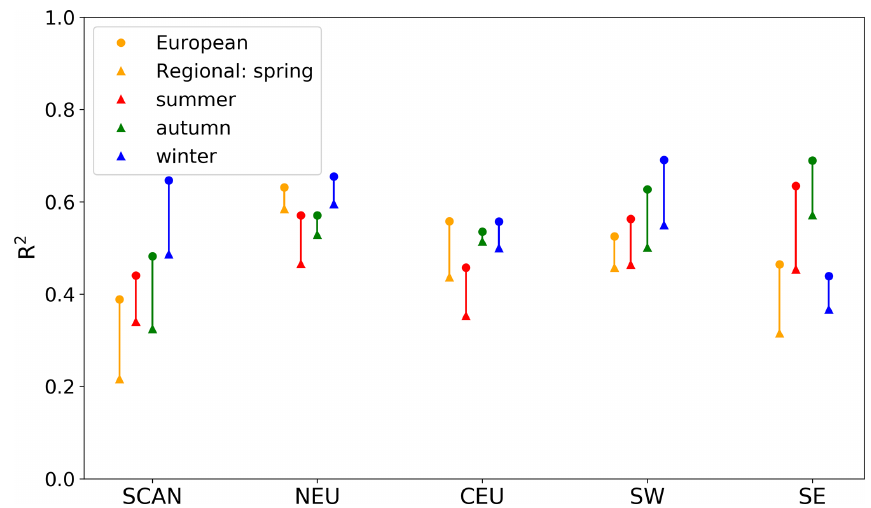
Figure 6. Skill of the stepwise multiple linear regression models ( R 2 ) of monthly air stagnation in each region and season (colours) during 1979–2018. Skills are shown for the regional models (triangles) and the European models (circle). See text for an explanation of the regional and European